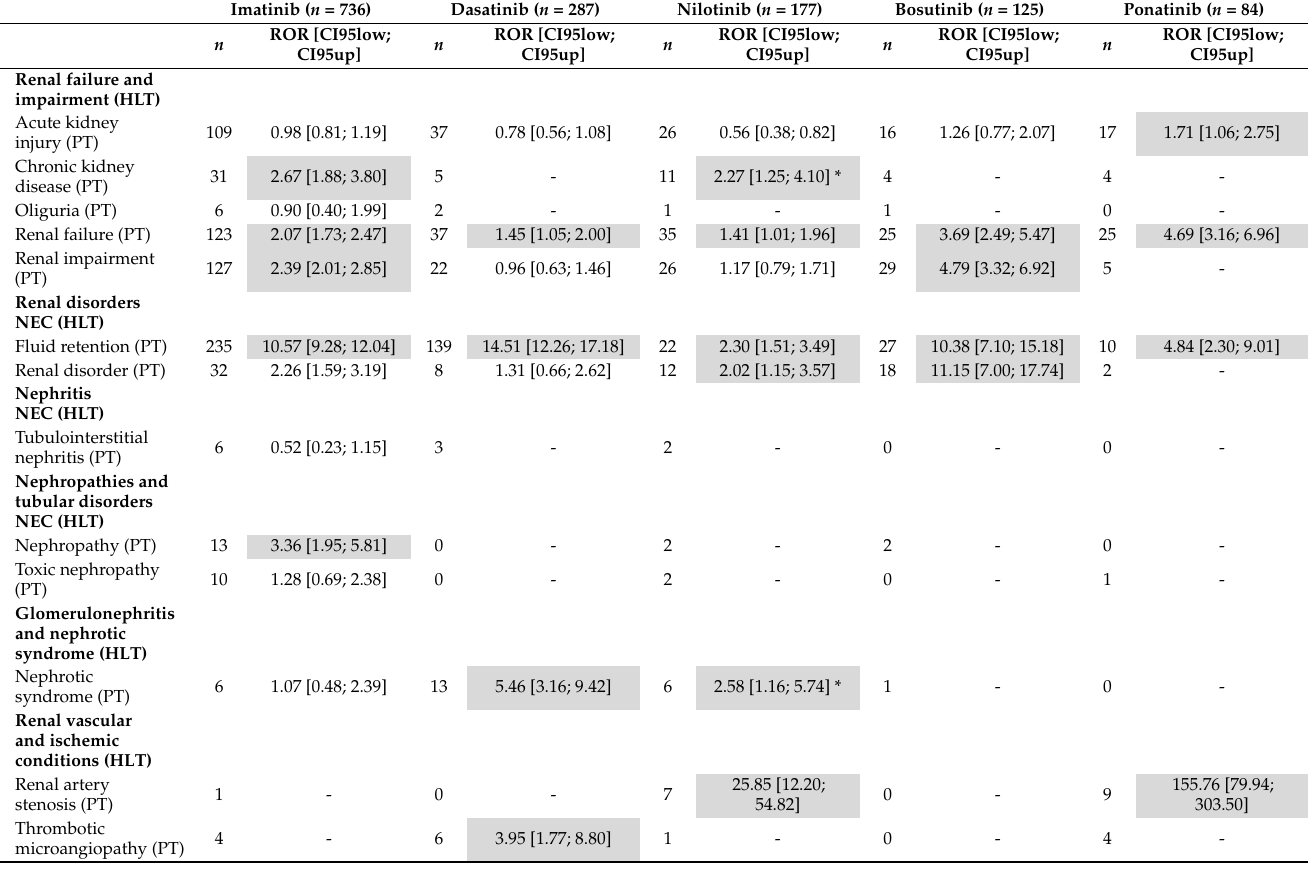
Table A2. Reporting odds ratio from standard disproportionality analyses for the selected preferred term